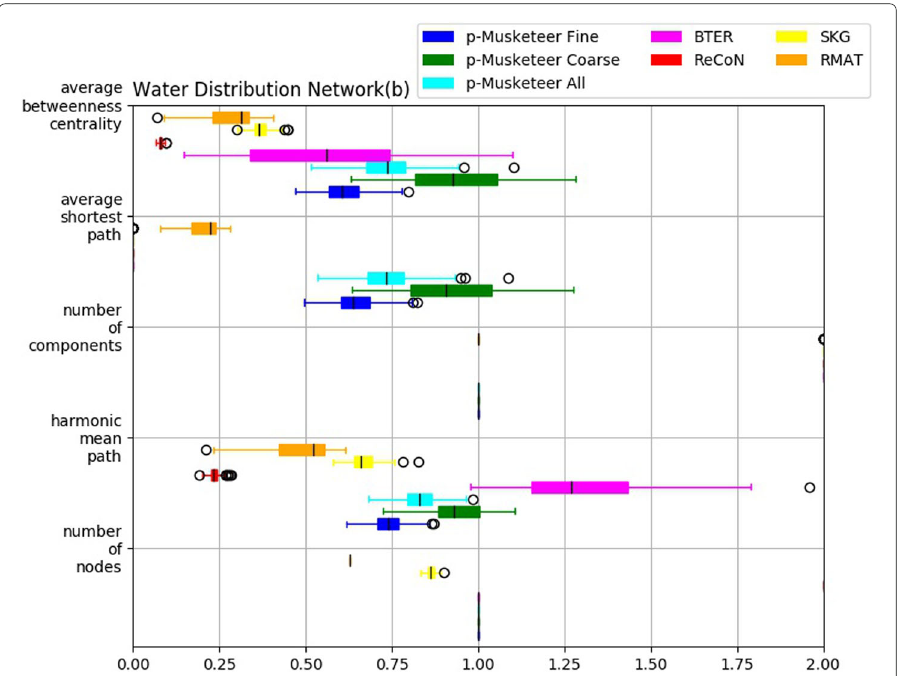
Fig. 7 Computational results on performance of planar Musketeer on real water network with 407 nodes and 459 edges for number of nodes, harmonic mean path, number of components, average shortest path and average betweenness